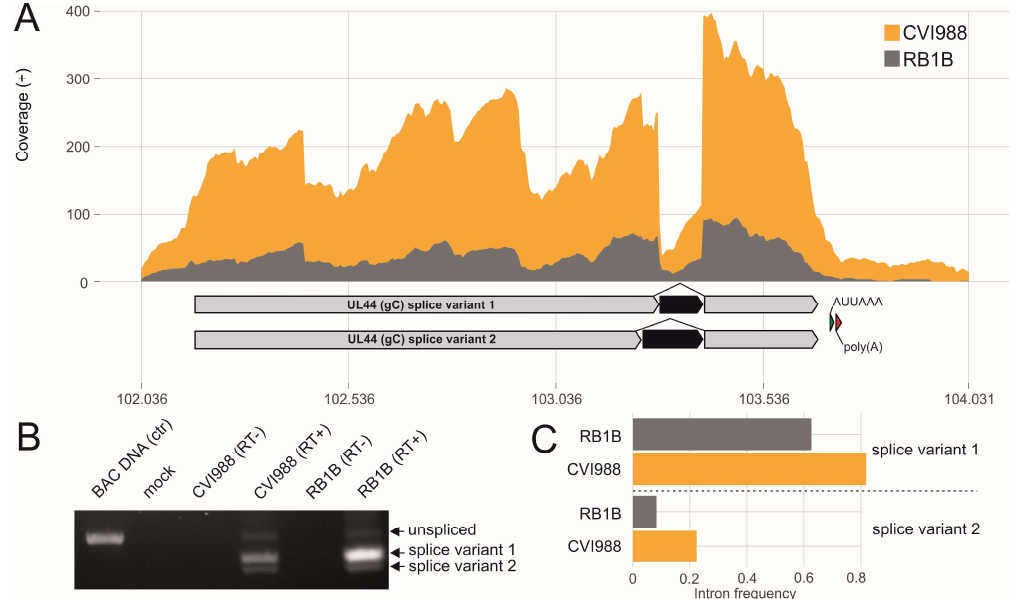
Figure 4. Glycoprotein C (gC) splicing. ( A ) Visualization of RNA-seq coverage across the Marek’s disease virus (MDV) gC gene UL44 with respective introns in black. The green and red arrow indicate the canonical ATTAAA polyadenylation signal and the poly(A) cleavage site respectively. ( B ) RT-PCR was performed to validate gC splicing. PCR products were derived using forward/reverse primers to amplify the respective intron-flanking regions. ( C ) Comparison of the gC intron frequencies in RB1B and CVI988 infected primary chicken B cells.